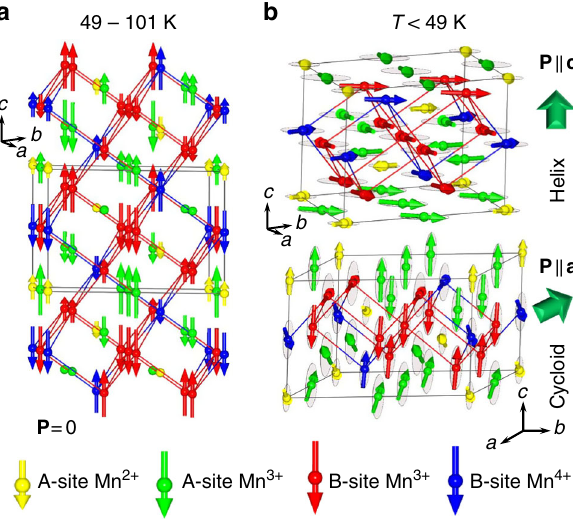
Fig. 4 Magnetic structures of the perovskite-type Mn 2 O 3 . a Schematic representations of the magnetic structure in the commensurate high- temperature phase (49 K < T < 101 K). This structure is a longitudinal spin density wave with the unit cell eight times bigger than the cell of the parent ffiffiffi p ffiffiffi p ffiffiffi p R (cid:1) 3 (2 a ´ 2 a ´ a 2 2 3 ) structure. It combines two types of the B-site p p p and three types of the A-site Mn-layers stacked along the c -axis. b Schematic representations of the magnetic structure in the incommensurate low-temperature phase ( T < 49 K). This structure combines both cycloidal and helical components. P refers to the induced electric